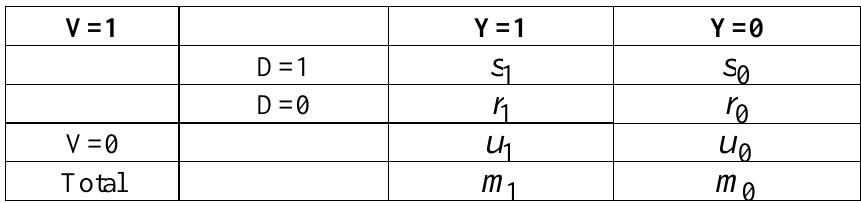
Table 12 . One binary